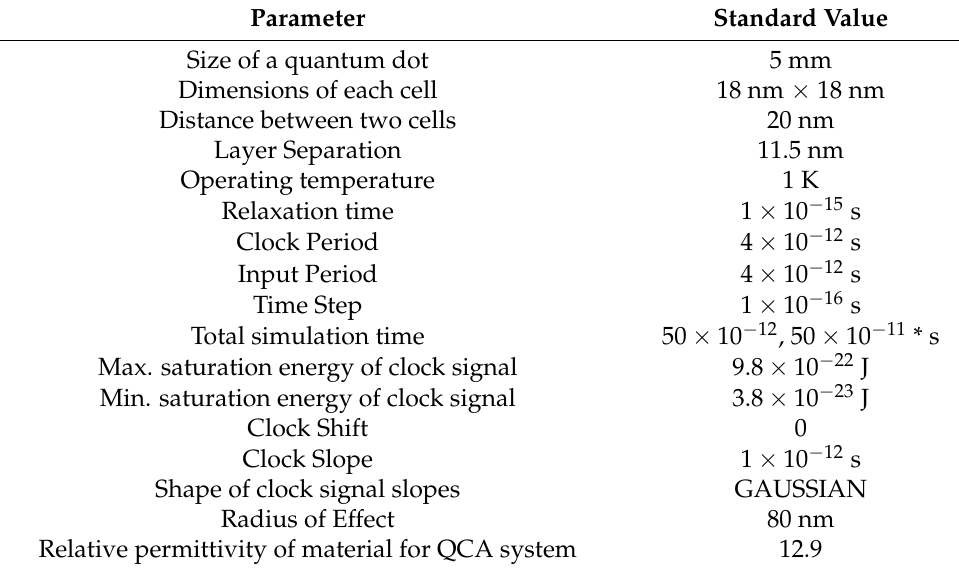
Table 2. QCA DesignerE settings for simulations.